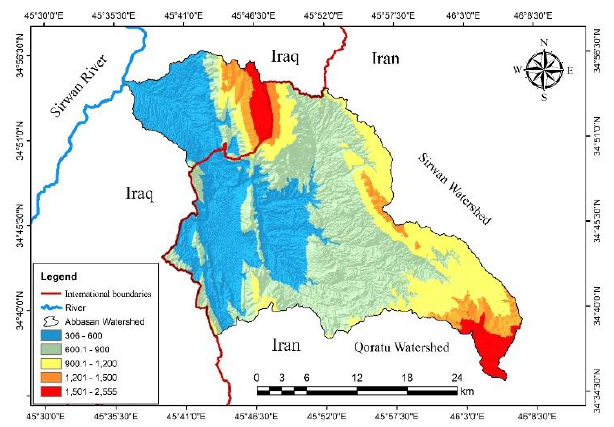
Figure 2: Topographic map of Abbasan watershed in between Iraq and